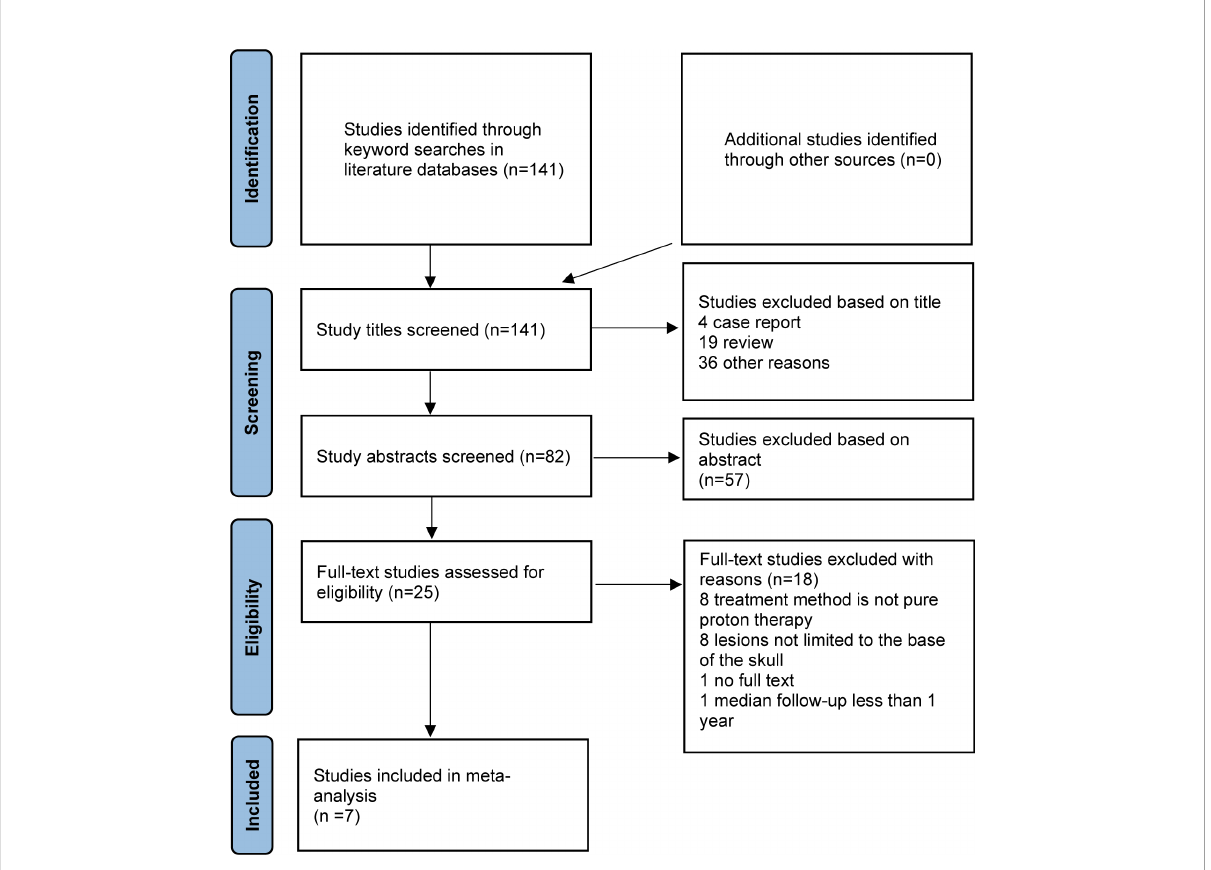
FIGURE 1 PRISMA fl owchart of the literature screening